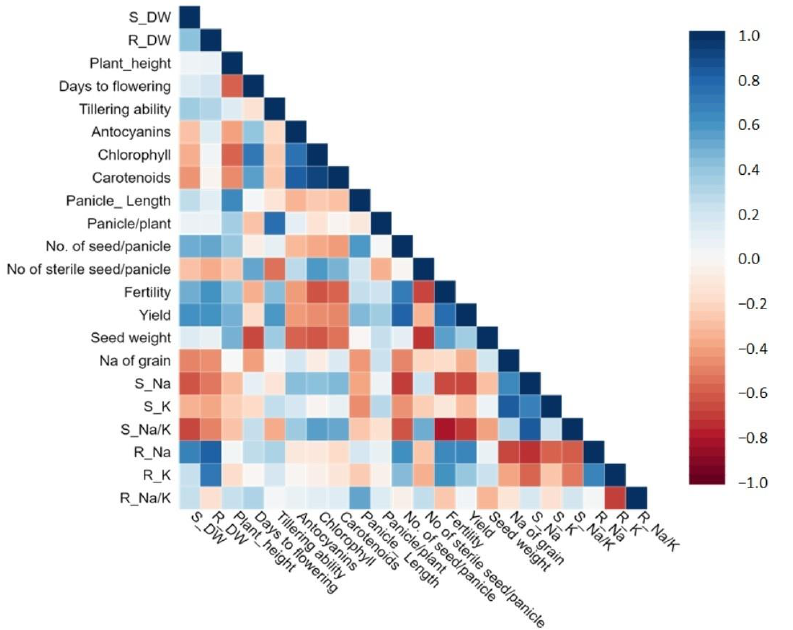
Figure 5. Pearson correlation among studied parameters. The correlation matrix contains the mean of the rice varieties’ data together under control and saline conditions.